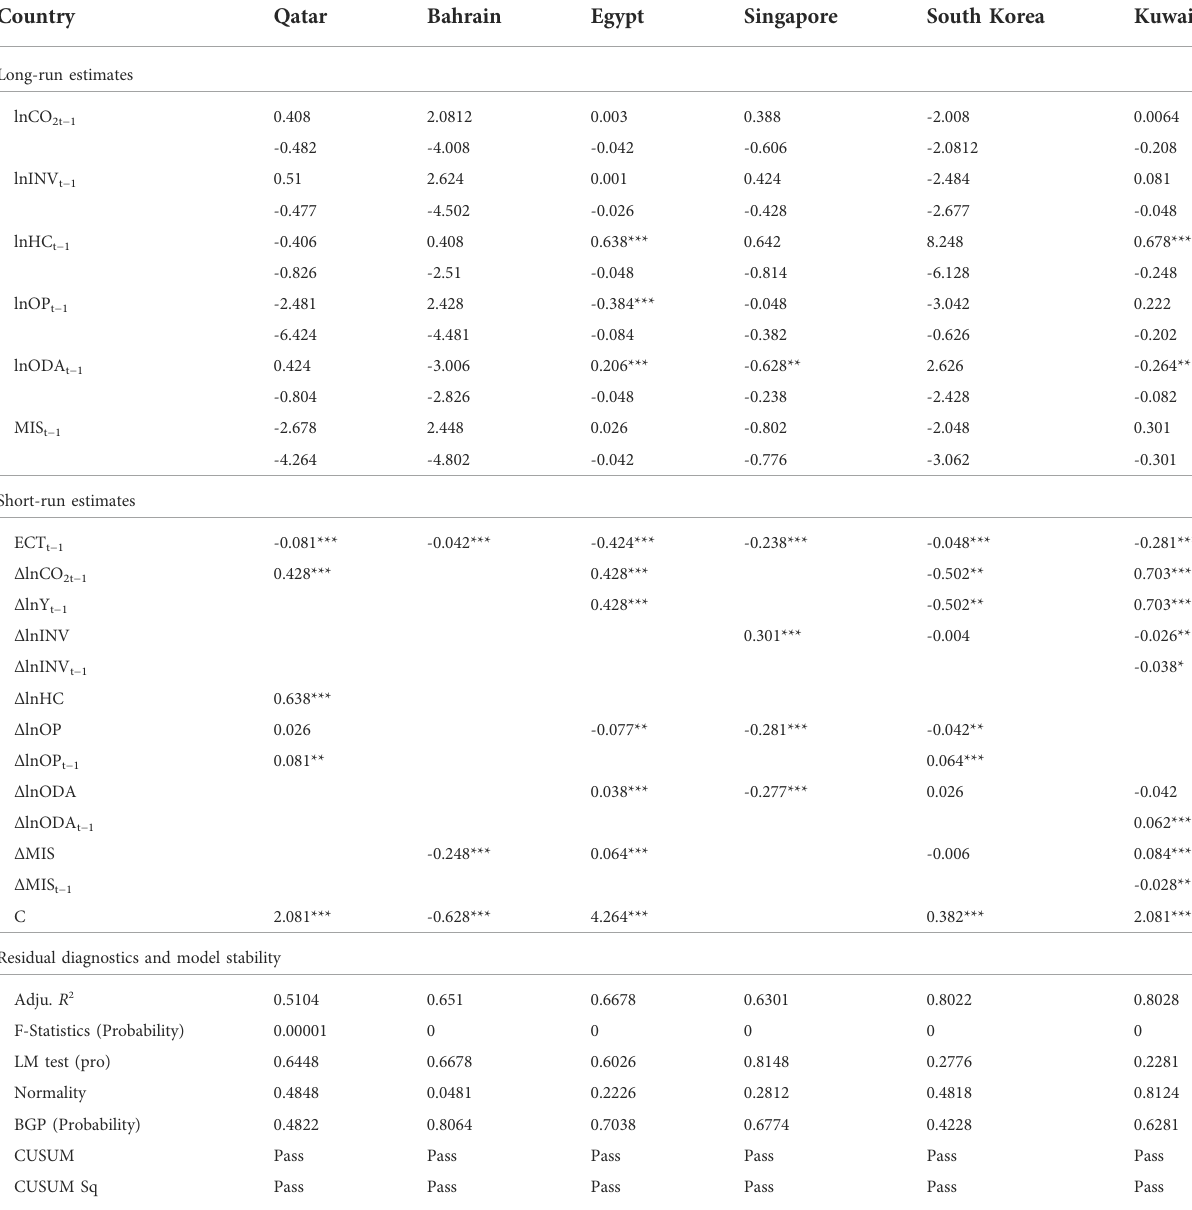
TABLE 11 Coef fi cients of ARDL estimation for the growth model.